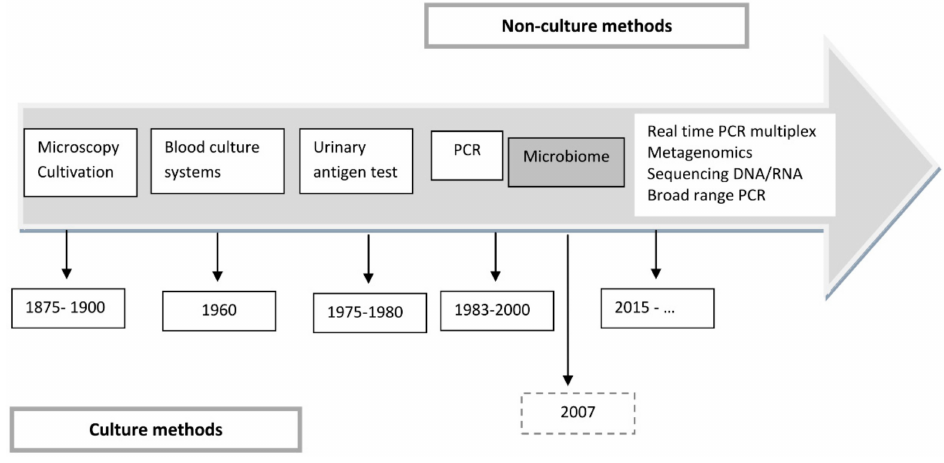
Figure 2. Evolution of diagnostic test for